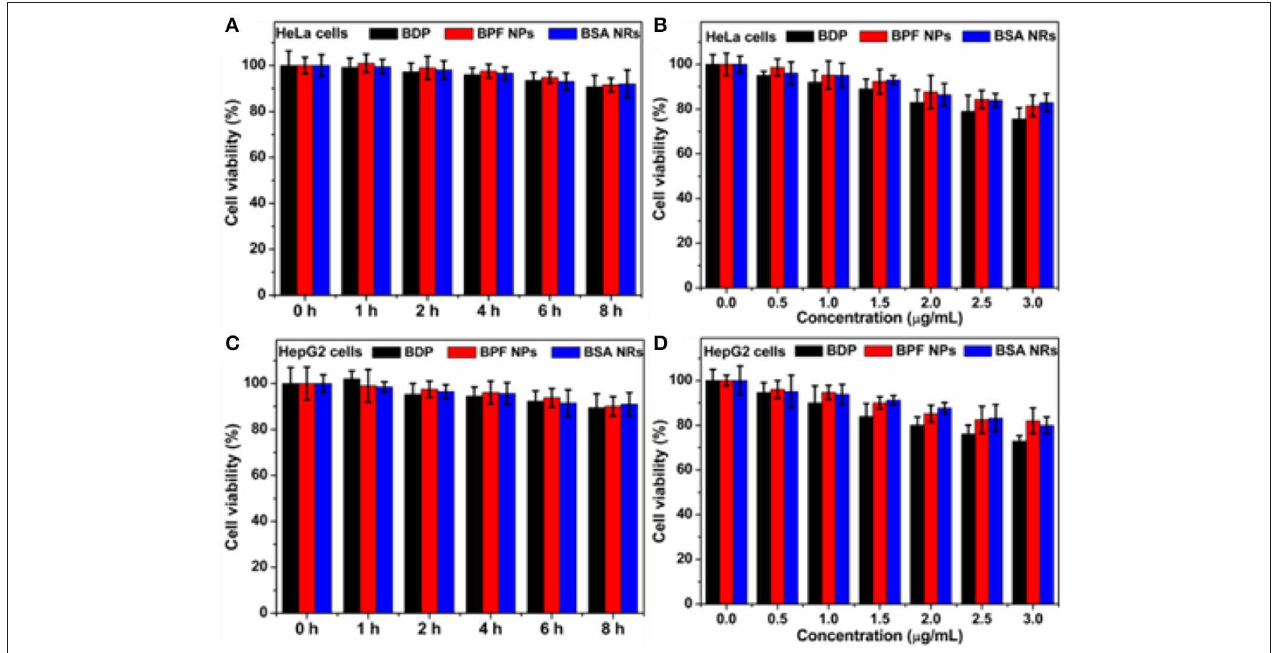
FIGURE 3 | (A) Cell survival rate of HeLa cells after incubation with BDP, BPF NPs, and BSA NRs for different hours, respectively. (B) Cell survival rate of HeLa cells after incubation with various concentrations of BDP, BPF NPs, and BSA NRs for 24h, respectively. (C) Cell survival rate of HepG2 cells after incubation with BDP, BPF NPs, and BSA NRs for different hours, respectively. (D) Cell survival rate of HepG2 cells after incubation with various concentrations of BDP, BPF NPs, and BSA NRs for 24h, respectively. Data represent mean values ± standard deviation, n =